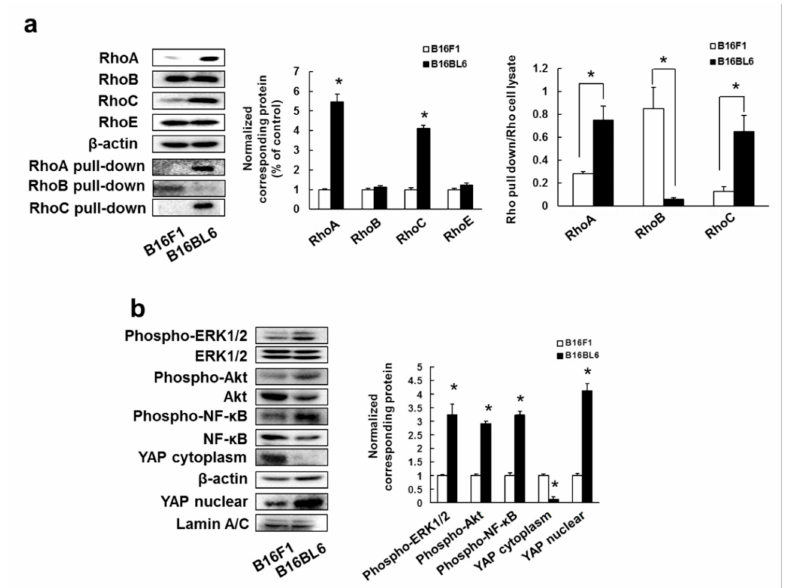
Figure 1. B16BL6 cells enhanced expression and activation of RhoA and RhoC: ( a ) Images of West- ern blots for the RhoA, RhoB, RhoC, RhoE, RhoA-GTP form (RhoA pull-down), RhoB-GTP form (RhoB pull-down), RhoC-GTP form (RhoC pull-down) and β -actin (internal standard), and quantifi- cation of the amounts of RhoA, RhoB, RhoC, RhoE, RhoA pull-down, RhoB pull-down, and RhoC pull-down after normalization to the amounts of corresponding protein. The results are repre- sentative of 4 independent experiments. * p < 0.01 vs. B16F1 cells (ANOVA with Dunnett’s test); ( b ) Images of Western blots for the phospho-ERK1/2, ERK1/2, phospho-Akt, Akt, phospho-NF- κ B, NF- κ B, YAP, β -actin, and lamin A/C, and quantification of the amounts of phospho-ERK1/2, phospho-Akt, phospho-NF- κ B, and YAP after normalization to the amounts of corresponding protein. The results are representative of 4 independent experiments. * p < 0.01 vs. B16F1 cells (ANOVA with Dunnett’s